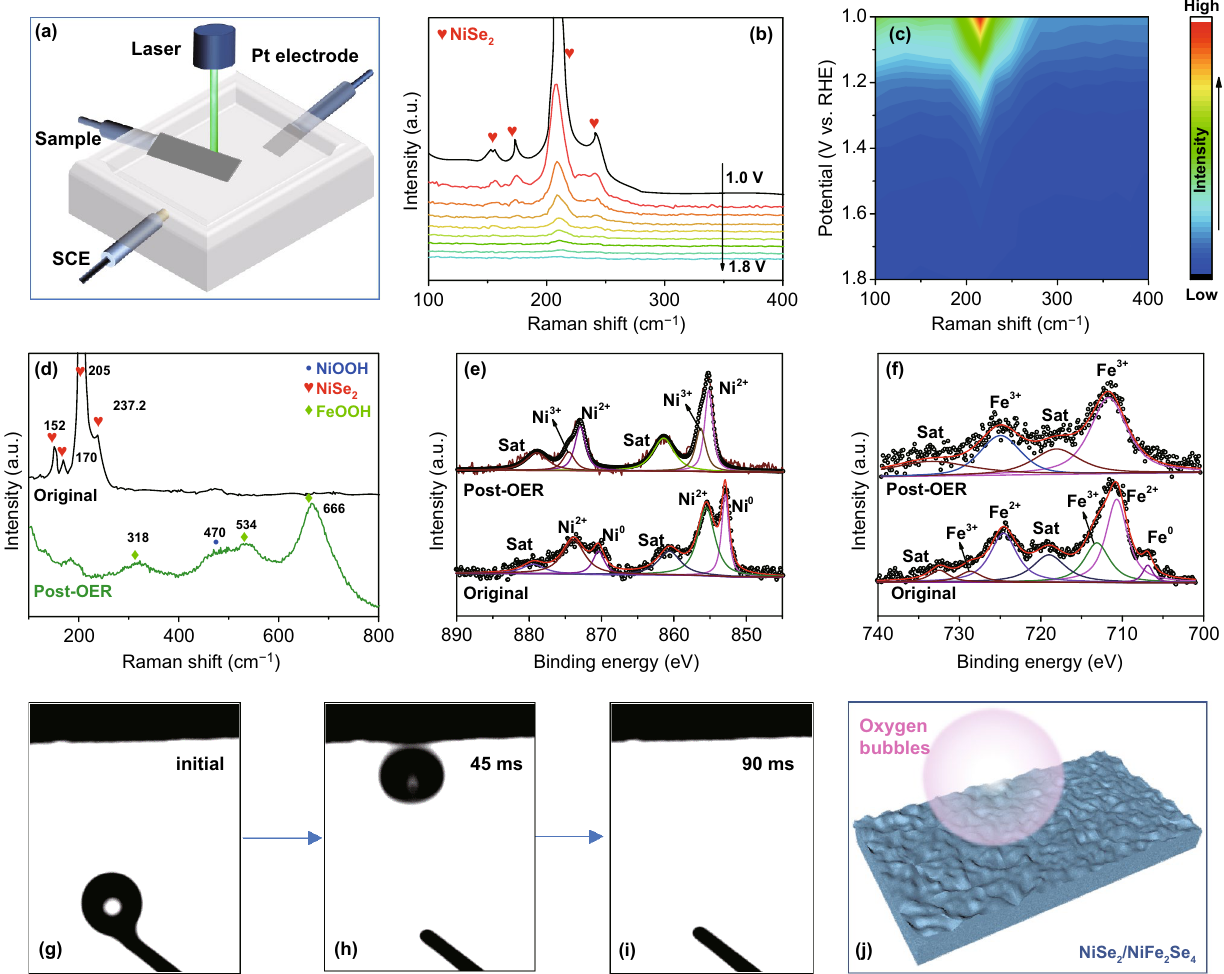
Fig. 4 a Digital images of in-situ electrochemical Raman spectroscopy for NiSe 2 /NiFe 2 Se 4 @NiFe during OER process. b In-situ Raman spectra and c corresponding contour plots of NiSe 2 /NiFe 2 Se 4 @NiFe at various potentials. d Raman spectra of NiSe 2 /NiFe 2 Se 4 @NiFe before and after OER tests. e , f High-resolution Ni 2 p and Fe 2 p XPS spectra of NiSe 2 /NiFe 2 Se 4 @NiFe before and after OER tests. g – i Digital images of O 2 bub- bles on NiSe 2 /NiFe 2 Se 4 @NiFe. j Schematic illustration of the adhesion behavior for O 2 bubbles on NiSe 2 /NiFe 2 Se 4